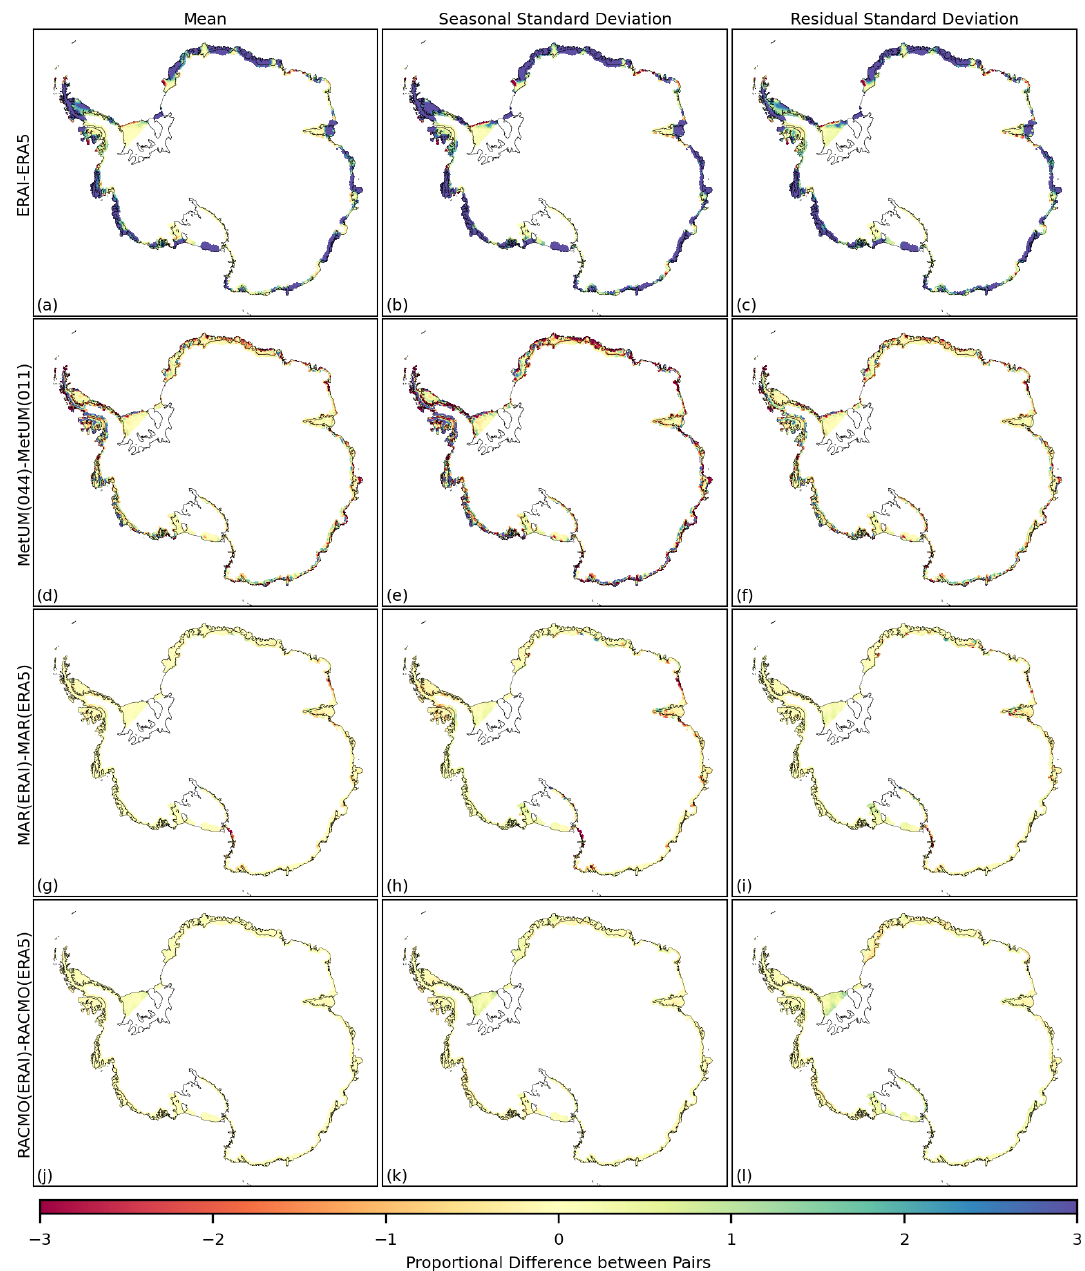
Figure B3. The difference for the 1981–2018 time series of melt, in the mean (a, d, g, j) , the standard deviation of the seasonal component (b, e, h, k) and the standard deviation of the residual component (c, f, i, l) between the following pairs of outputs: ERA-Interim relative to ERA5 (a–c) , MetUM(044) relative to MetUM(011) (d–f) , MAR(ERAI) relative to MAR(ERA5) (g–i) and RACMO(ERAI) relative to RACMO(ERA5) (j–l) . Differences at each grid cell are expressed as a proportion of average inter-annual variation and so do not have units. Grid cells where the ensemble mean average monthly melt is less than 1mmw.e. per month are masked.